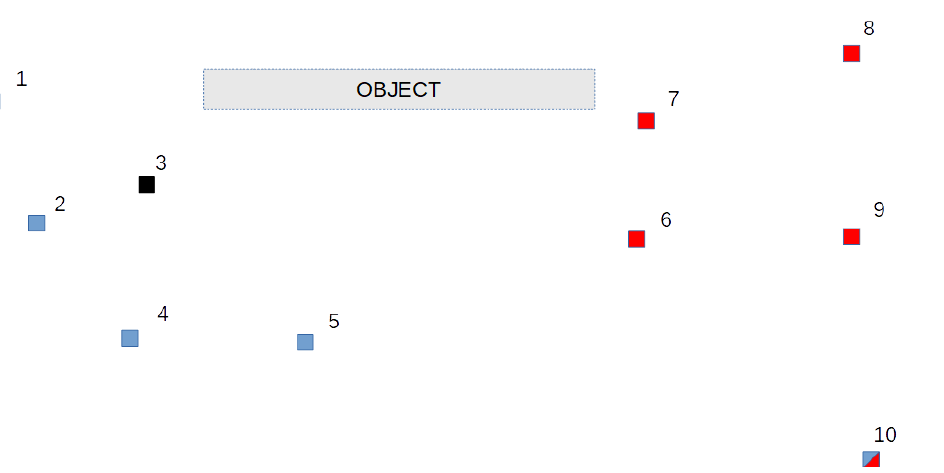
Table 1. Coordinates of points of the test object 1 for both epochs.